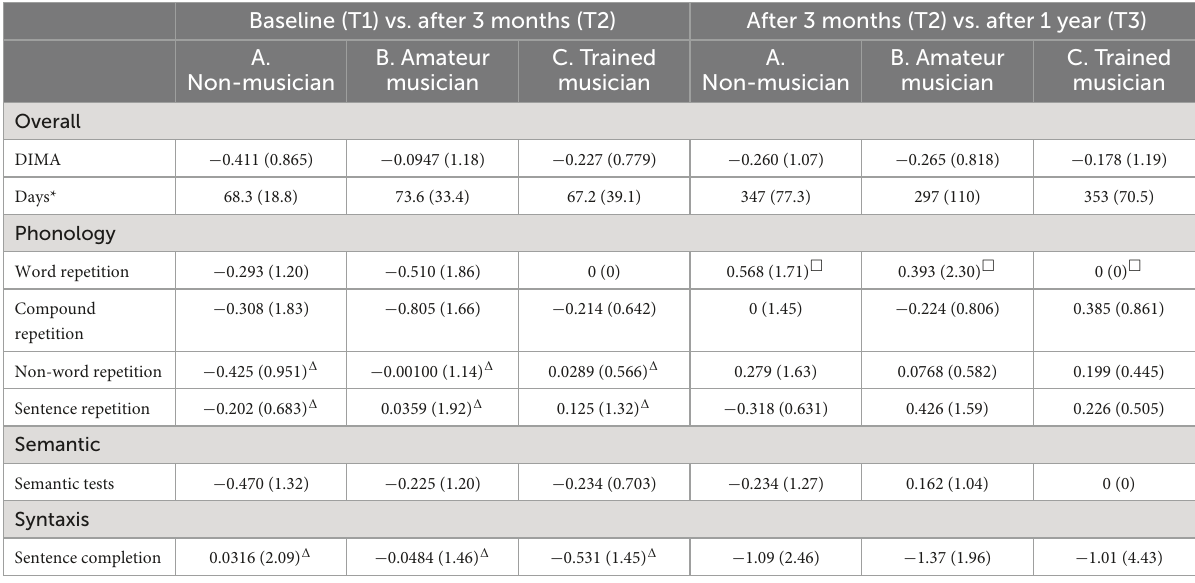
TABLE 2 DIMA scores vs.